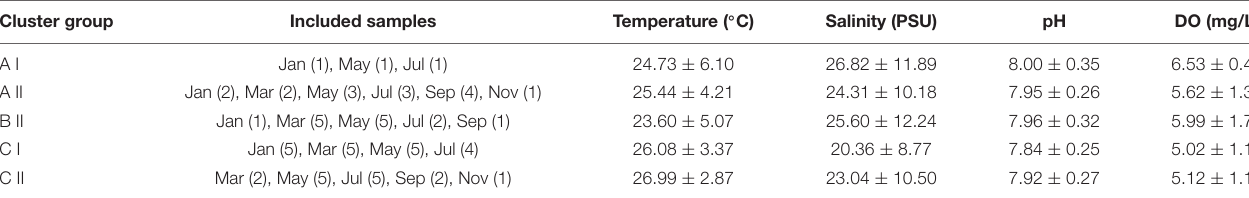
TABLE 3 | Average (mean ± standard deviation) temperatures, salinity, pH, and dissolved oxygen concentration (DO) of copepod species occurring in the samples included in Figure 6 . Cluster group Included samples